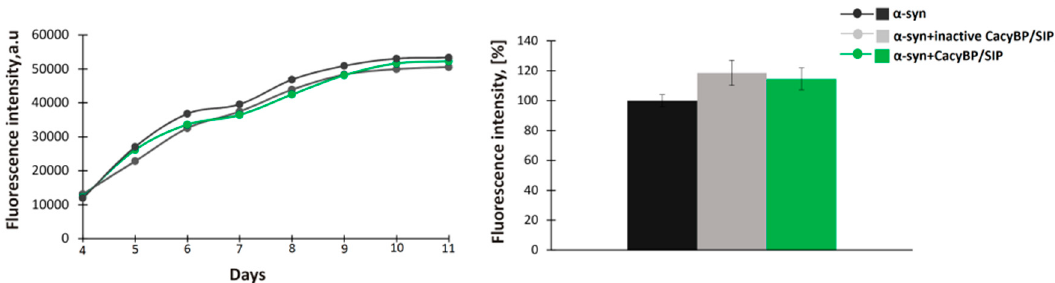
Figure 3. E ff ect of CacyBP / SIP on later stages of α -synuclein aggregation. ( Left panel ) Representative Figure 3. Effect of CacyBP/SIP on later stages of α -synuclein aggregation. ( Left panel ) Representative curves showing ThT fluorescence of 30 µ M α -synuclein alone (black) or in the presence of 30 µ M: curves showing ThT fluorescence of 30 µM α -synuclein alone (black) or in the presence of 30 µM: inactive CacyBP / SIP (grey) or CacyBP / SIP (green) added on day 4. ( Right panel ) Statistical analysis inactive CacyBP/SIP (grey) or CacyBP/SIP (green) added on day 4. ( Right panel ) Statistical analysis of the results of samples taken on day 6 ( n = 3). Data, calculated as means ± SEM, are presented as percentage